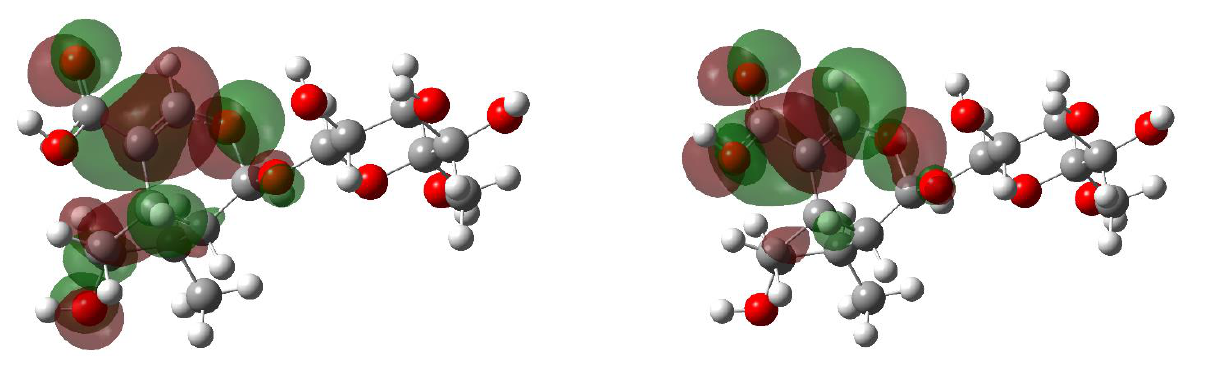
Figure 4. HOMO – LUMO plots of loganic acid. Figure 4. HOMO–LUMO plots of loganic